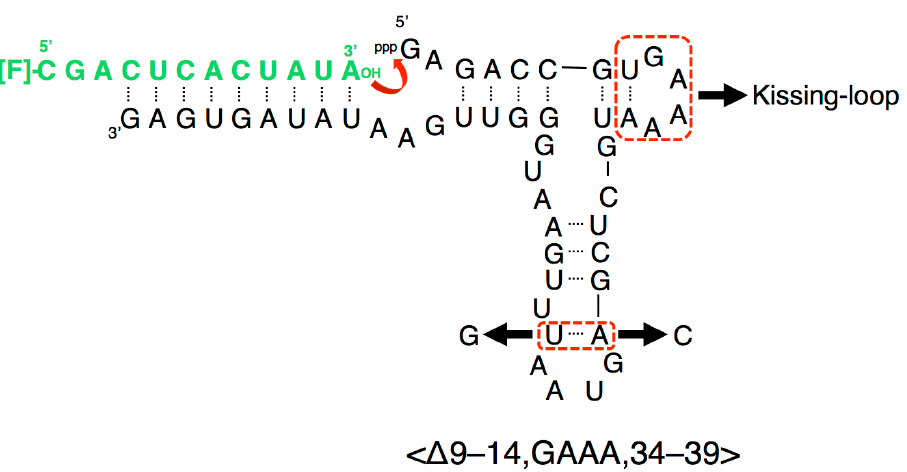
Figure 2. Composition of a variant of the R3C ligase ribozyme, < ∆ 9–14,GAAA,34–39>, with a fluorescence-labeled RNA substrate [12]. Although the addition of only one more base pair to the “grip” region showed greater than 10% activity of the full-length R3C (< ∆ 9–14,GAAA,35–39>), < ∆ 9–14,GAAA,34–39> showed a drastic decrease of activity [12]. We introduced seven-membered single-stranded nucleotides, expecting the inter-molecular interaction through the kissing-loop, and replaced the A–U pair at the end of the grip stem with C–G. Because U51 is proximal to U50 of the A33–U50 pair, the A33–U51 pair can also be stacked on P4; however, this is not possible with the C–G pair (nucleotide position from Figure 1).